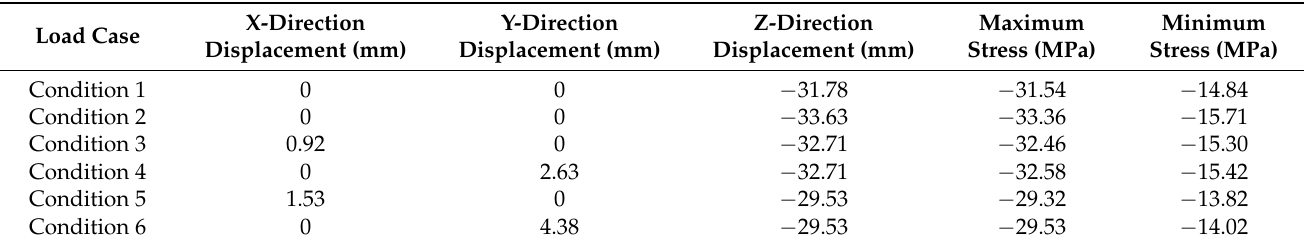
Table 2. Deformation and stress data for the truss under various